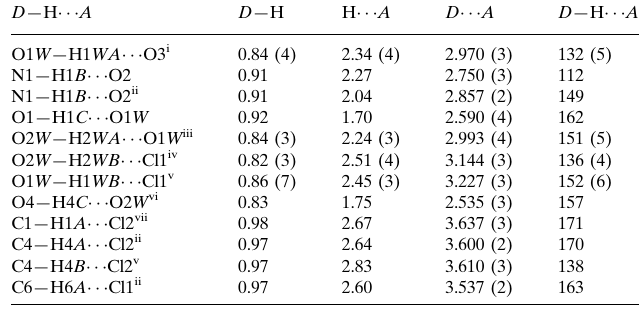
166 parameters 9 restraints